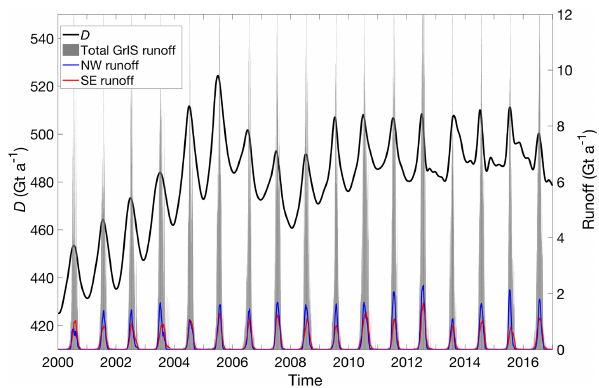
Figure 6. Cumulative GrIS D (black, left y axis) plotted with raw daily runoff totals (gray bars, right y axis). The timing of the sea- sonal maximum runoff is emphasized by vertical dotted lines. Re- gional runoff totals, smoothed by a 31-day running mean, are shown for the NW and SE